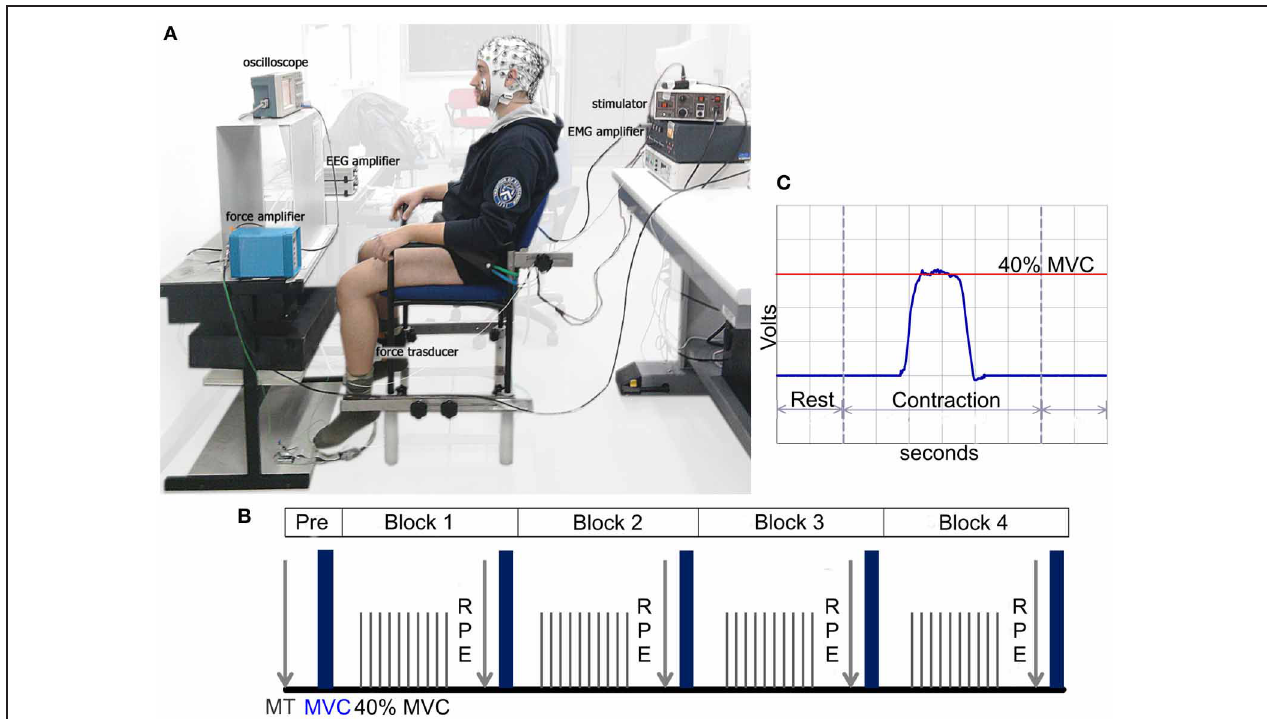
baseline. Each block includes 60 self-paced isometric contractions at 40% of the MVC followed by the rating of perceived effort (RPE), MT, and MVC. (C) Real-time visual force feedback regarding the subject’s current force level produced by the leg displayed on the oscilloscope